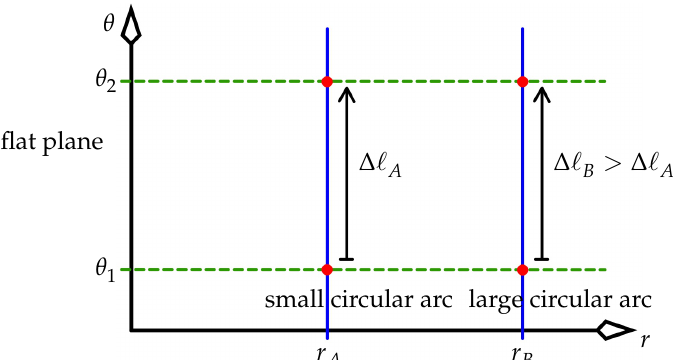
Figure 9. The flat plane of two-dimensional space in polar coordinates r , θ , drawn analogously to the spacetime of Figure 7. Two circular arcs, both centred on the origin r = 0, become the blue straight lines in this figure. The metric that describes a length d (cid:96) in space is position dependent: d (cid:96) 2 = d r 2 + r 2 d θ 2 . Certainly ∆ (cid:96) B > ∆ (cid:96) A (the outer arc is longer than the inner arc), but we